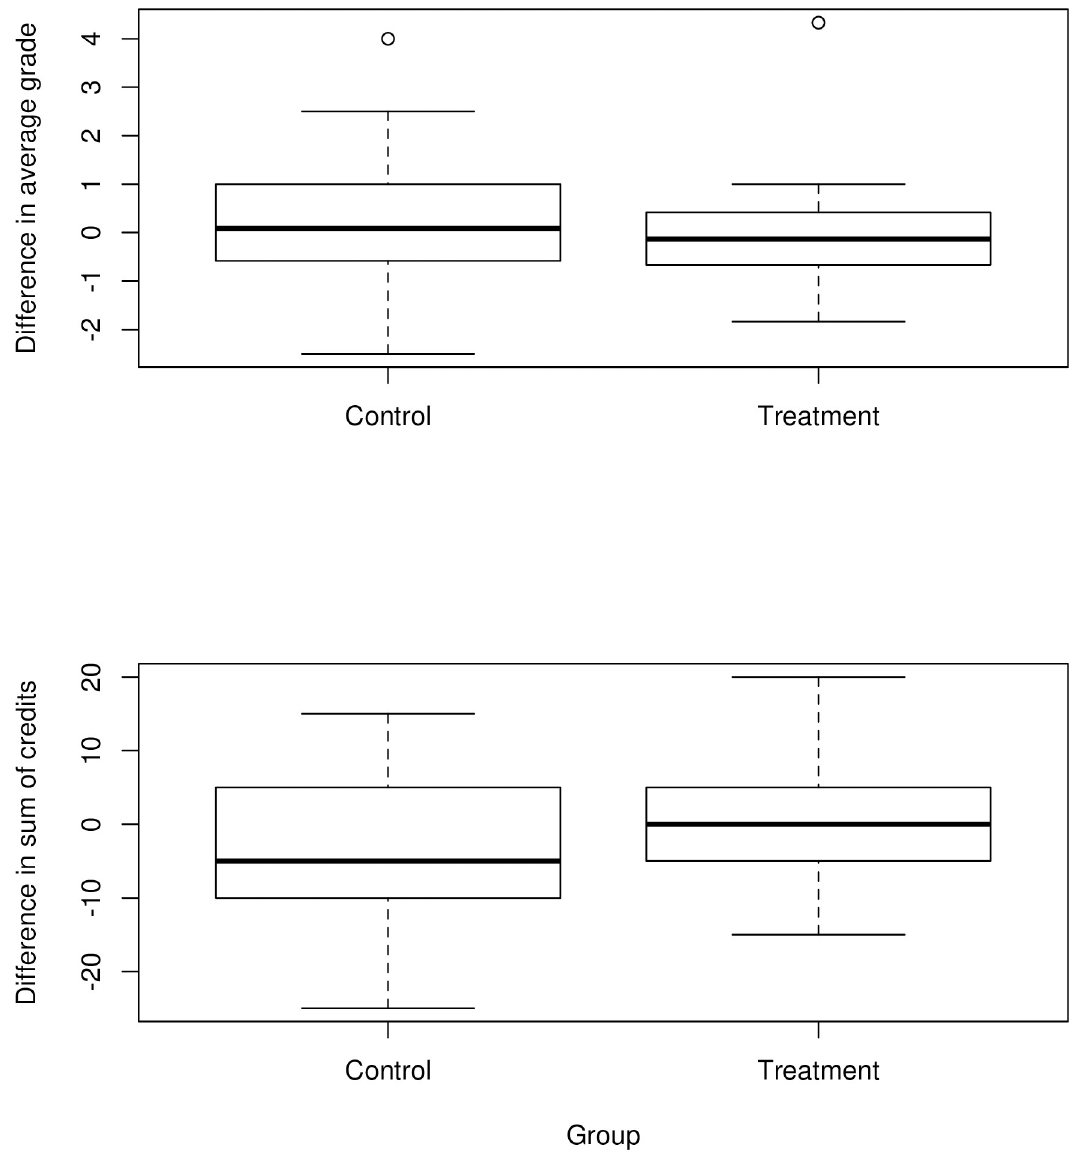
Fig 4. Differences in academic